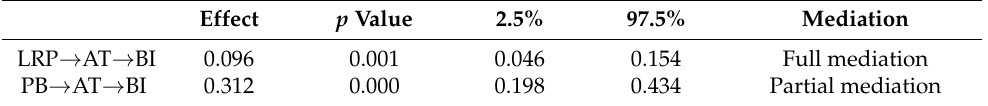
Table 8. The mediation effect of attitude toward GBA